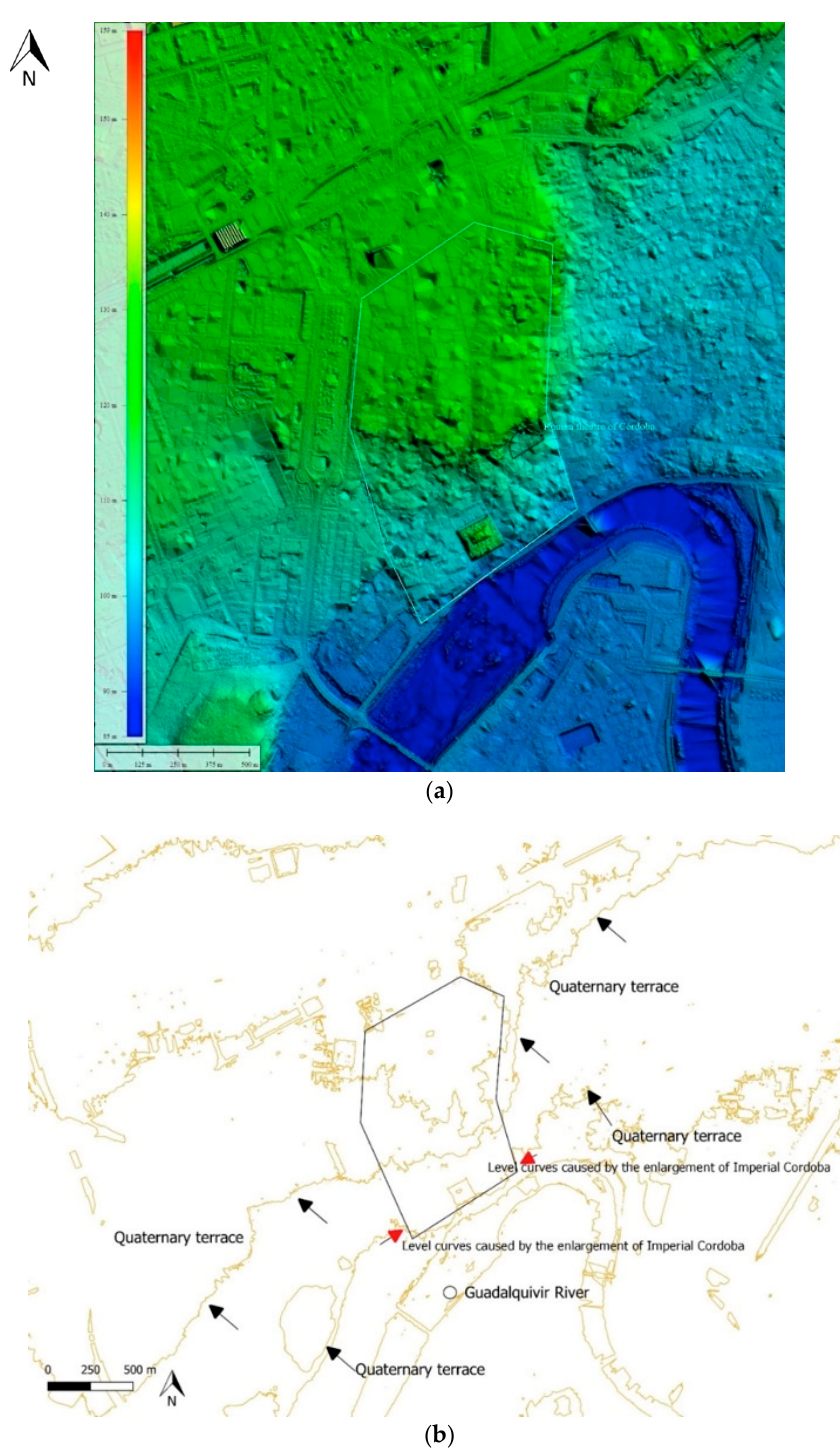
Figure 7. ( a ): Enlargement of Imperial Roman Cordoba (with the site of the Roman theatre) generated from the LAS files. The ©PNOA-LiDAR 2016 CC-BY 4.0 ign.es files were processed with the Global Mapper 18.1 colour ramp hillshader by Antonio Monterroso-Checa. ( b ): The extraction of the slope lines shows how the new Roman city occupied the ancient zone and floodable area of the river. The contour lines indicate the southern limits of the walls of this enlargement; the quaternary terrace has been completely altered in this point by the construction of this new Roman city. Slope lines were extracted with QGIS 3.4.3. by Antonio Monterroso-Checa.